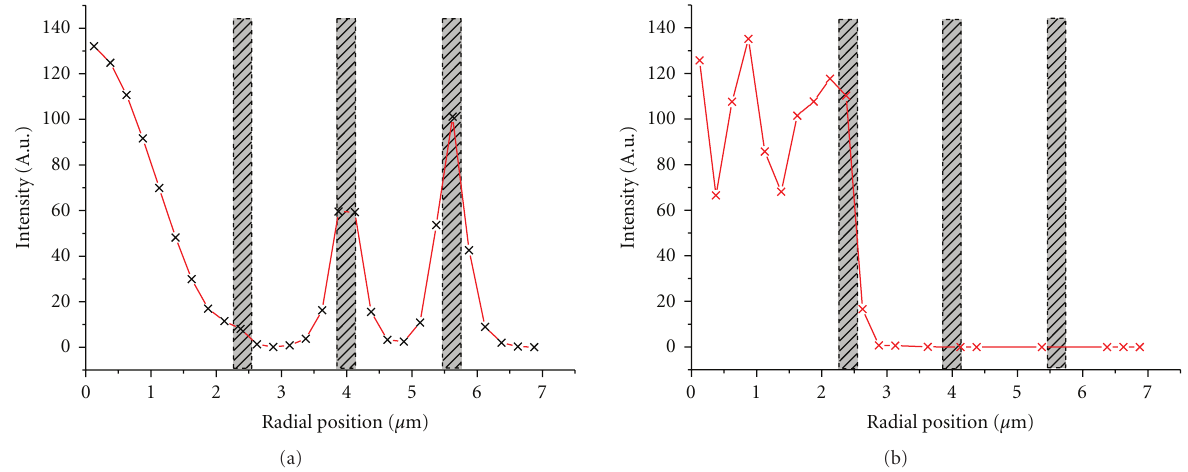
Figure 12: Plot of intensity distribution with respect to the radial position of (a) liquid-filled HCPCF and (b) LCPCF. Gray regions indicate silica walls in the